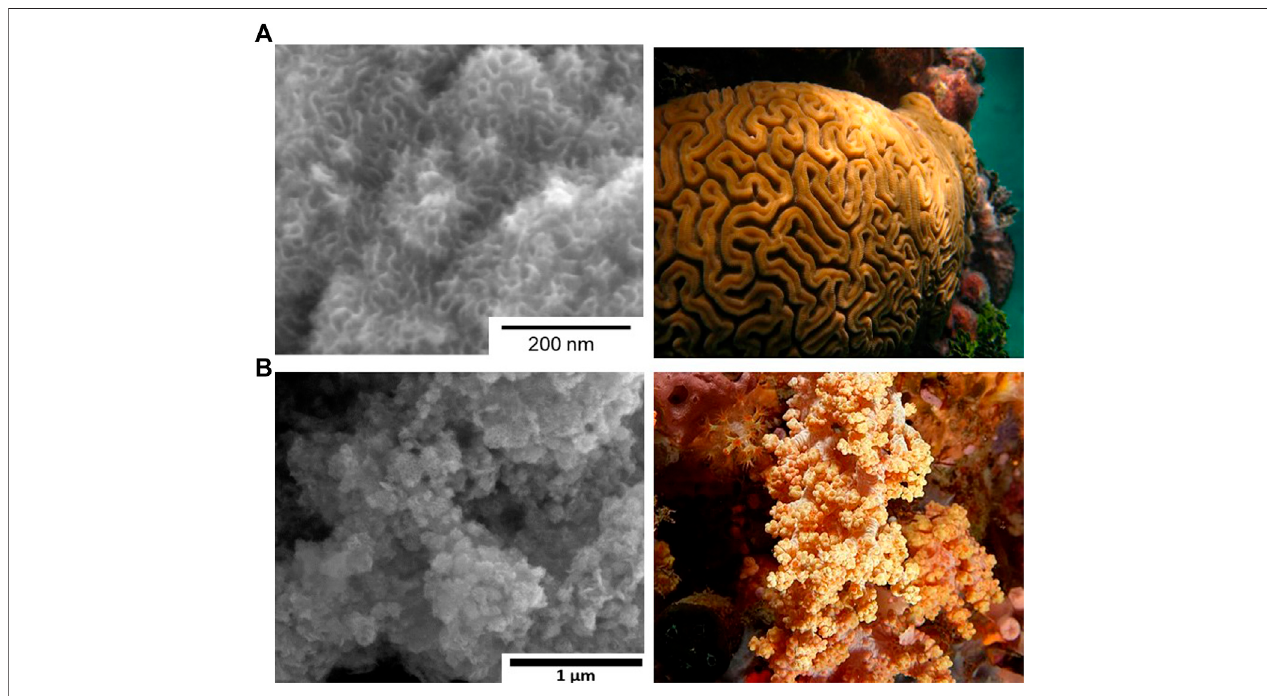
FIGURE6 | (A) SEM of self-assembled Ptnanoneedles with nanocoral morphology (Reprinted from Electrochim. Acta 354 (2020) 136608.©2020 Elsevier Ltd.All rights reserved), compared to brain coral (Diploria labyrinthiformis) (licensed under Creative Commons 3.0. Available on: https://upload.wikimedia.org/wikipedia/ commons/9/92/Mozgovity_koral.jpg). (B) SEM of Pt-Co 3 O 4 HSS (Reprinted from Catalysts 2020, 10 (11), 1311. MDPI, Basel, Switzerland under the terms and conditions of the Creative Commons Attribution (CC BY) license), compared to Scleronephthya spp . (Licensed under the Creative Commons